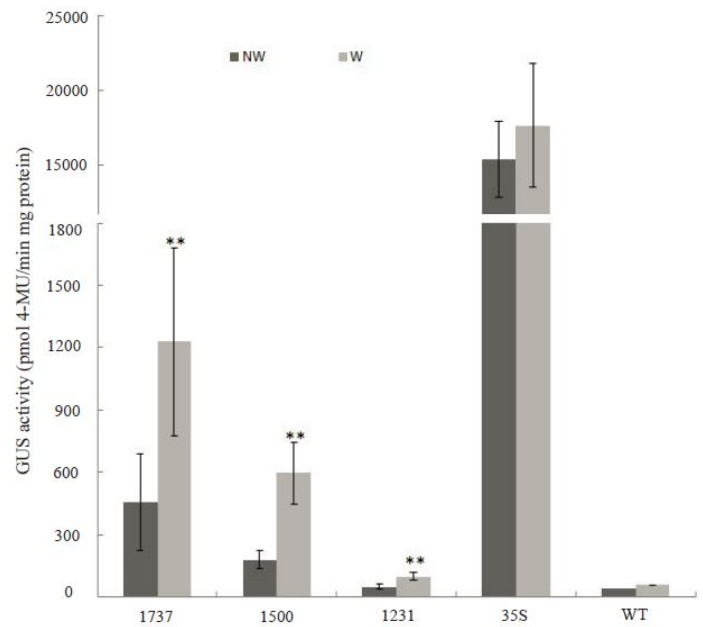
Figure 10. GUS activity in transgenic rice leaves treated with wounding. The second leaves from apex of 40-day-old rice plants grown in a greenhouse were wounded using the method described in Xu, et al. [28]. NW and W mean non-wounded or wounded samples. Data was shown as average ± S.E. of 6 independent transgenic lines. Asterisks (**) means the significant difference at p < 0.01